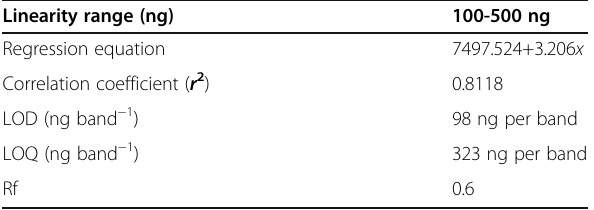
Table 2 Rf value and linear regression data for HPTLC analysis of